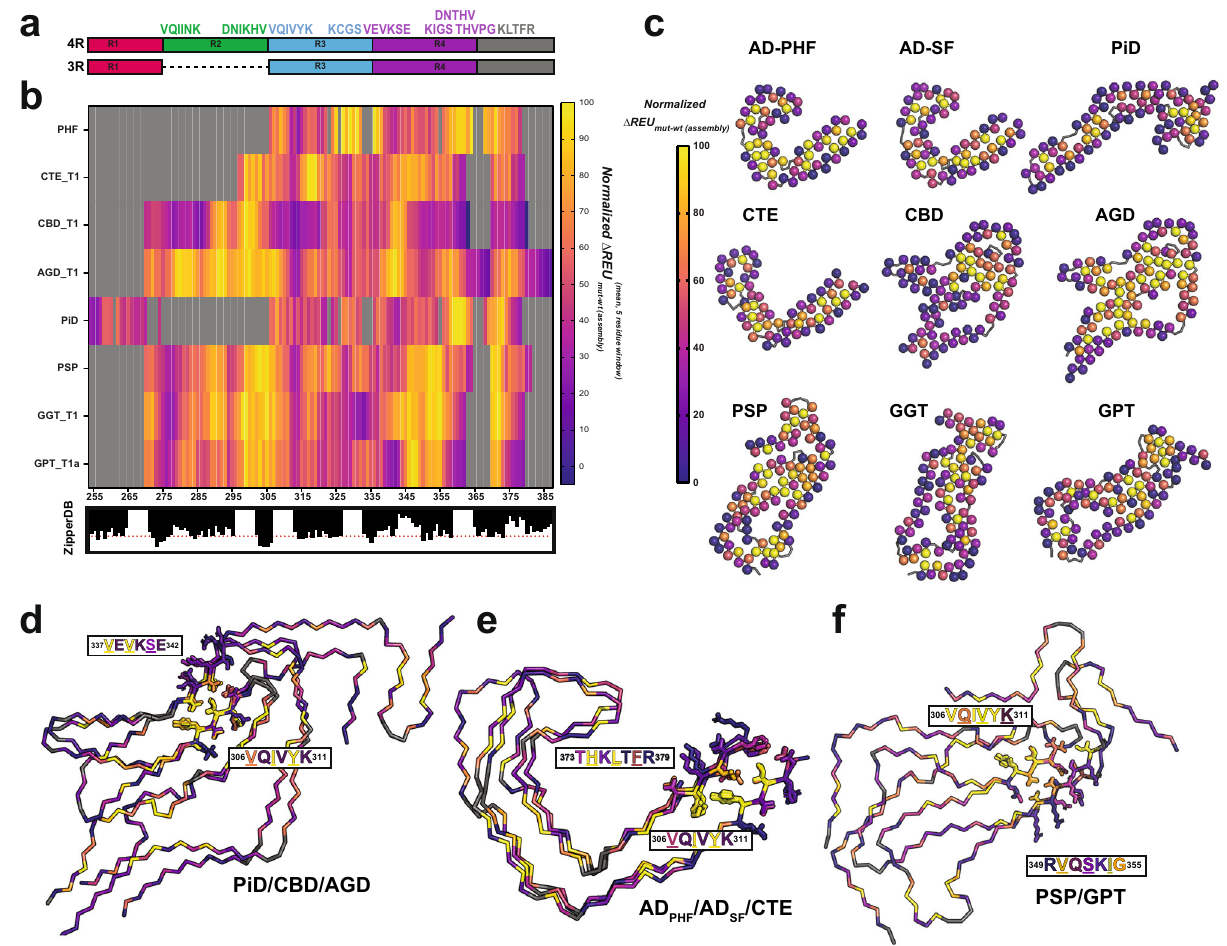
Fig. 4 | Fibril alanine scanning uncovers modular networks of hotspot inter- actionsintau fi brils.a Cartoonillustrationof4Rand3Risoformsofthetaurepeat domains colored as in Fig. 1a highlighting location of key amyloidogenic motifs shown above. b Normalized heatmap of energetic change in response to sub- stitution to alanine across a 5-residue window for 9 prototypical tau fi bril struc- tures: AD-PHF, CBD_T1, CTE_T1, PiD, AGD_T1, PSP, GGT_T1a, and GPT_T1. PDB ids: 5o3l,6gx5,6nwp,6tjo,7p6d,7p65,7p66,and7p6a.Scaleiscoloredinplasmafrom yellow (important) to purple (not important). c Mapping per residue Δ REU assembly mut (cid:1) wt pro fi les onto the 9 tau fi bril structures uncovers inward-facing amino acids